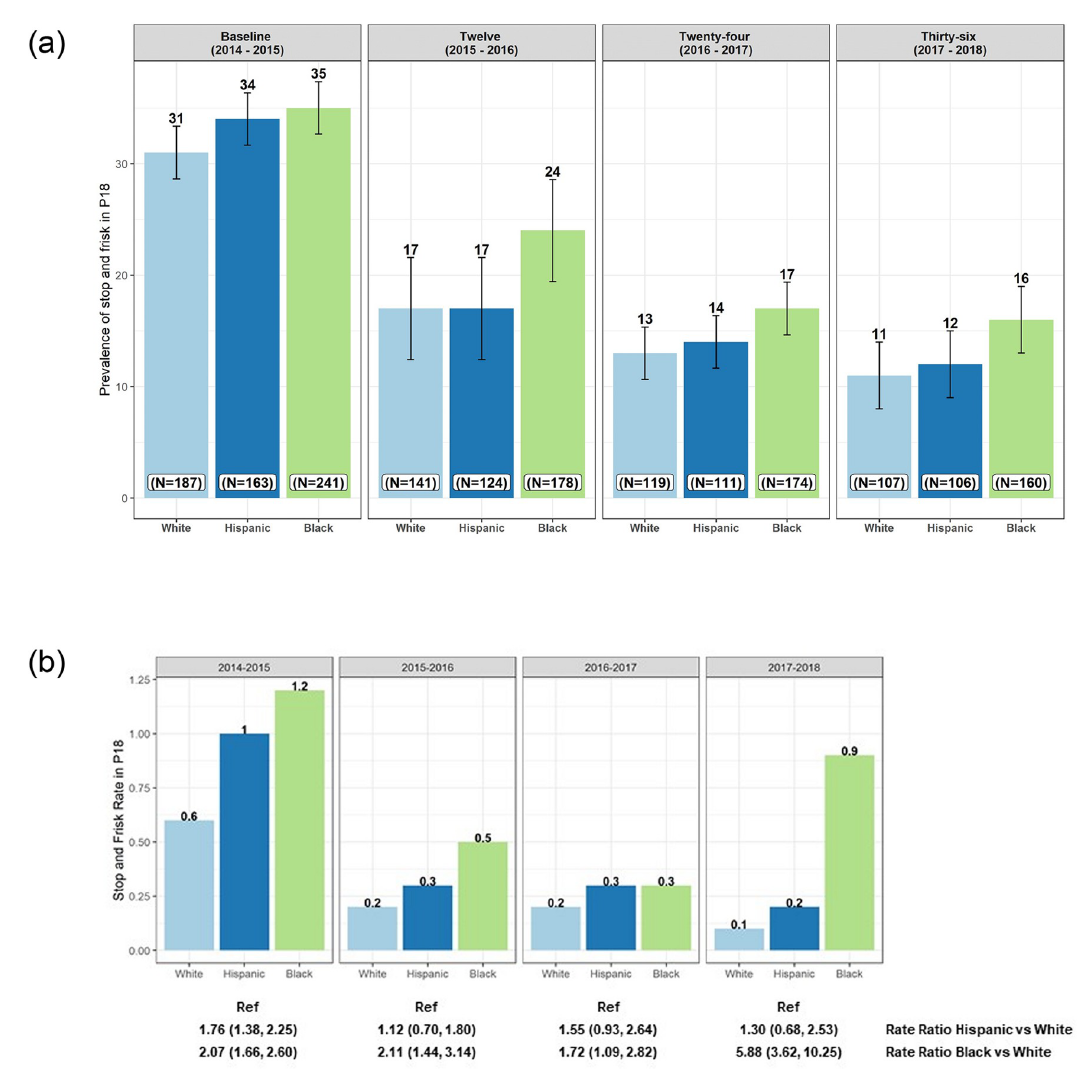
Fig 1. a. Race differences in past year stop-and-frisk prevalence of past year stop-and-frisk � among P18 participants over cohort follow-up (2014–2019; N = 591 at baseline). � P18 questionnaire item: “How many times have you been stopped, questioned, and/or frisked in the past year?” We coded a dichotomous indicator of any prior stop-and-frisk in the past year. In the sample overall, 32.3% reported being stopped-and-frisk at baseline and 21.5% reported being stopped-and-frisked at least once over the course of the follow-up. b. Race differences in past year stop-and-frisk rate � among P18 participants over cohort follow-up (above bar chart) and unadjusted rate ratios (RRs) and 95% confidence intervals (CIs) for associations between race and stop-and-frisk rate (below table) (2014–2019; N = 591 at baseline). � P18 questionnaire item: “How many times have you been stopped, questioned, and/or frisked in the past year?” P18 rates were calculated as the race-specific number of stop-and-frisk events reported by P18 participants/race- specific P18 study population times 1,000. Note: Rate among Black P18 participants at the 36-month visit was driven by a high stop rate among one participant (66 stops in the past year); when this participant was excluded from the analysis the stop rate was reduced to 0.5 from 0.9 among the remaining